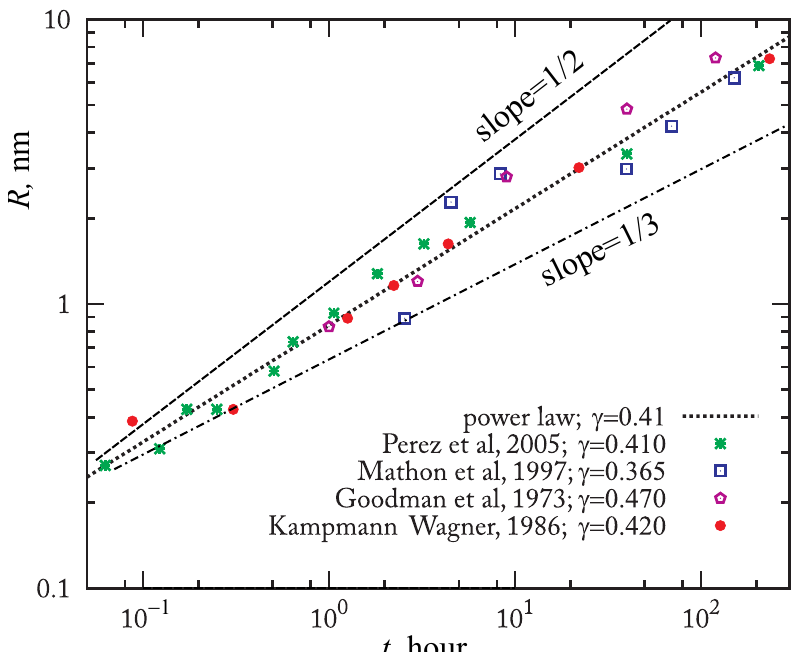
Figure 1. Experimental time dependencies of average radius of Cu precipitates in α -iron. Line is an approximation by a power law with exponent γ = 0.41. Slopes 1/2 and 1/3 in the log–log scale correspond to the case of normal diffusion-limited growth of isolated precipitate and the Ostwald ripening case,